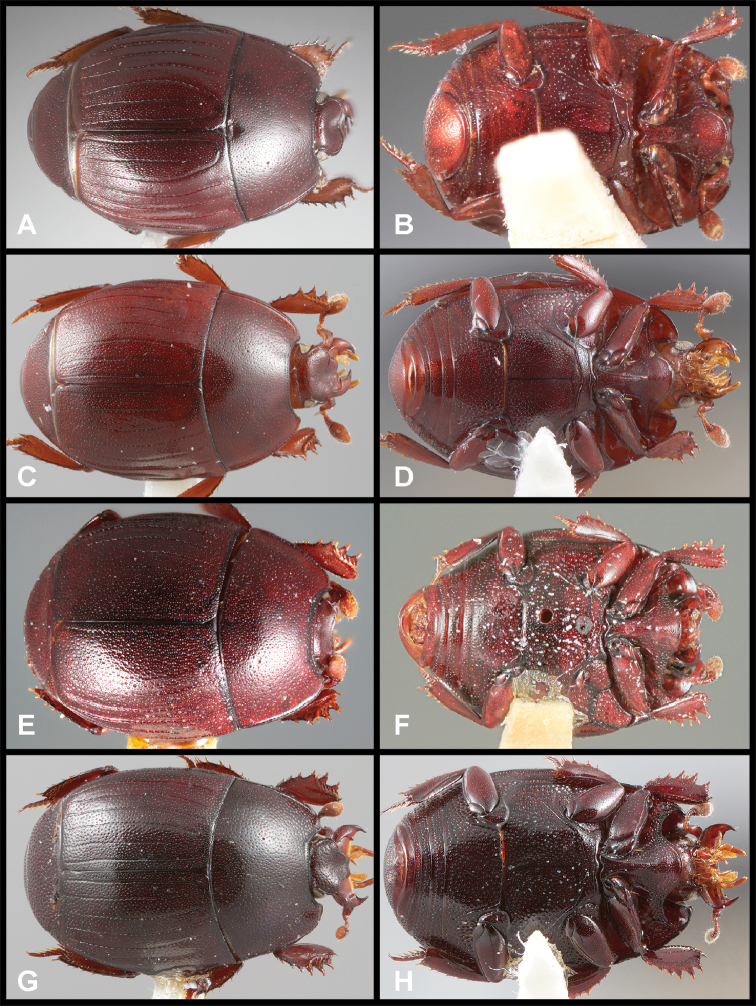
A, bPhelister
sculpturatus: A dorsal habitus B ventral habitus C, DP.
tunki: C dorsal habitus D ventral habitus E, FP.
praedatoris: E dorsal habitus F ventral habitus G, HP.
ifficus: G dorsal habitus H ventral habitus.